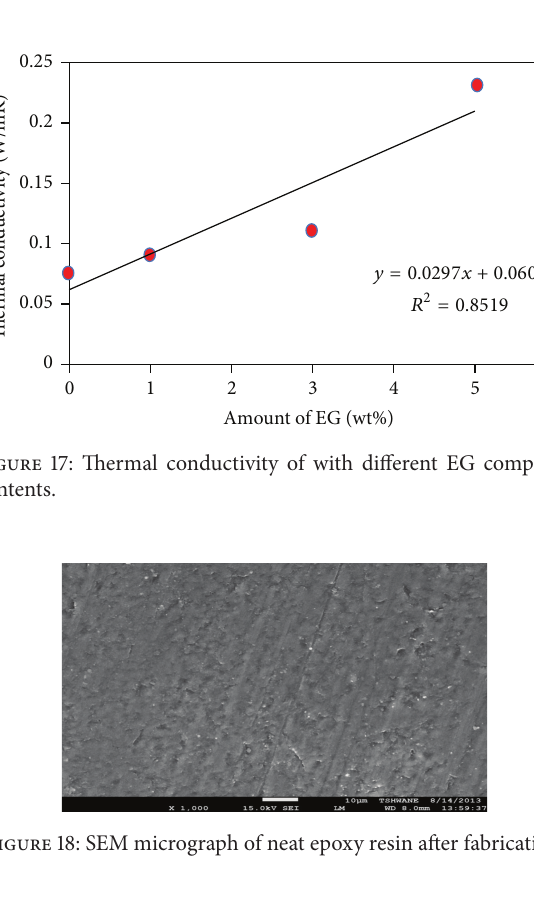
Figure 16: TGA thermograms of different epoxy-EG composites at the same heating rate 5 ∘ Cmin −1 .